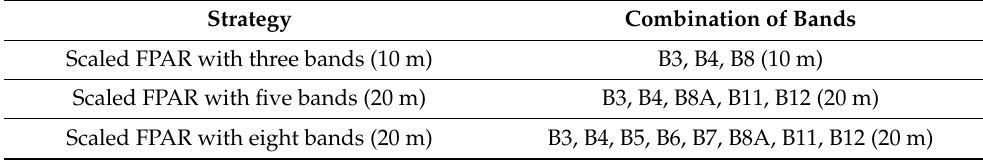
Table 2. Three combinations of bands used in the scaling-based FPAR retrieval chain. Strategy Combination of Bands Scaled FPAR with three bands (10 m) B3, B4, B8 (10 m) Scaled FPAR with five bands (20 m) B3, B4, B8A, B11, B12 (20 m) Scaled FPAR with eight bands (20 m) B3, B4, B5, B6, B7, B8A, B11, B12 (20